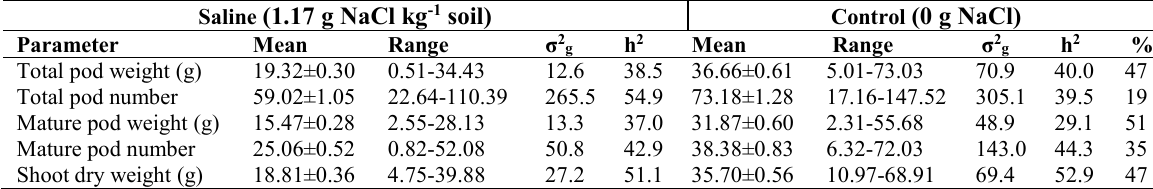
Table 3. Overall trial mean (± SE of mean), range of best linear unbiased predicted means of genotypes (BLUPs), genetic variance (σ 2 g ), heritability (h 2 ), and percentage reduction of mean parameter value under saline conditions compare to control (%) of pod weight, pod number, mature pod weight, mature pod number, and shoot dry weight (DW) measured at maturity under saline and control conditions in 275 groundnut genotypes at ICRISAT, Patancheru in